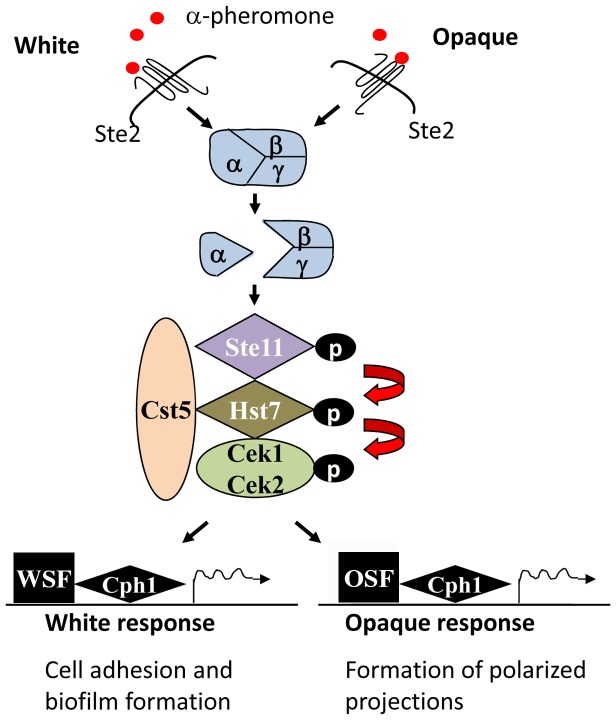
Model for pheromone signaling responses in C. albicans white and opaque cells.The same pheromone MAP kinase pathway operates in C. albicans white and opaque cells, and activates downstream responses via the same transcription factor, Cph1. White- and opaque-specific factors (WSF and OSF, respectively) work in concert with Cph1 to drive phase-specific phenotypes. The interactions with Cph1 could either be direct or indirect. In response to pheromone, C. albicans opaque cells undergo efficient polarized growth and cell conjugation. In contrast, white cells cannot mate but can form pheromone-stimulated biofilms under certain environmental conditions.